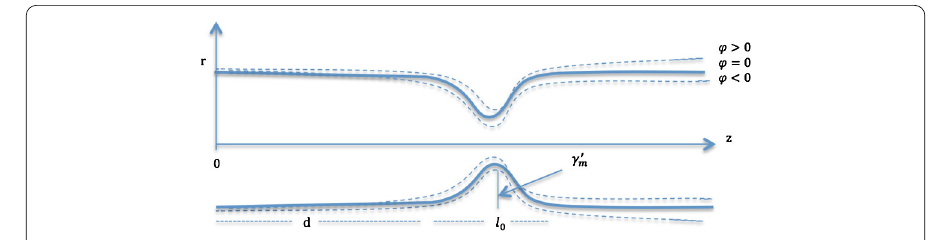
Figure 1 Two-dimensional stenosed and tapering